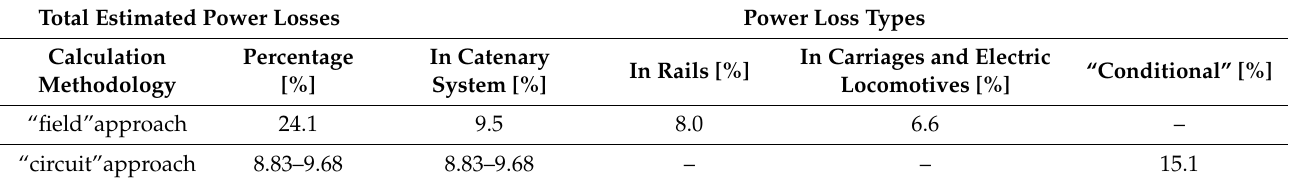
Table 6. Comparison of calculation results obtained by different